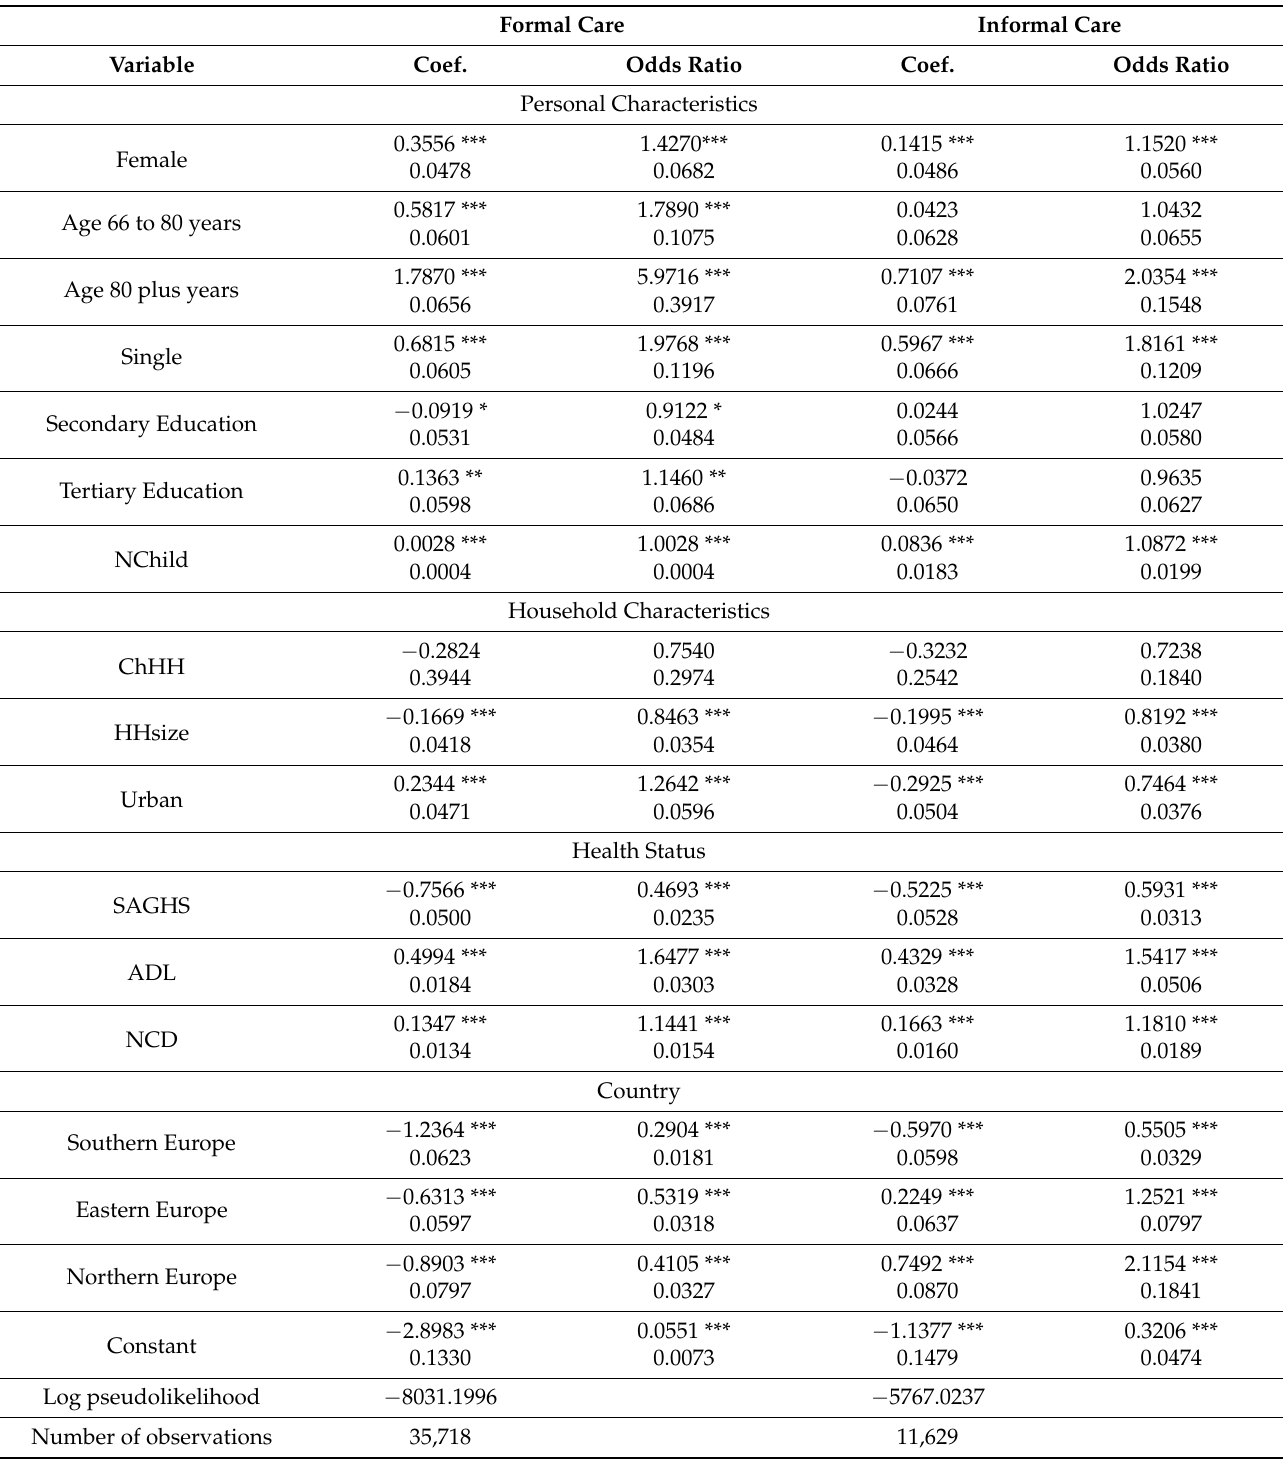
Table 3. Estimates for formal care and informal